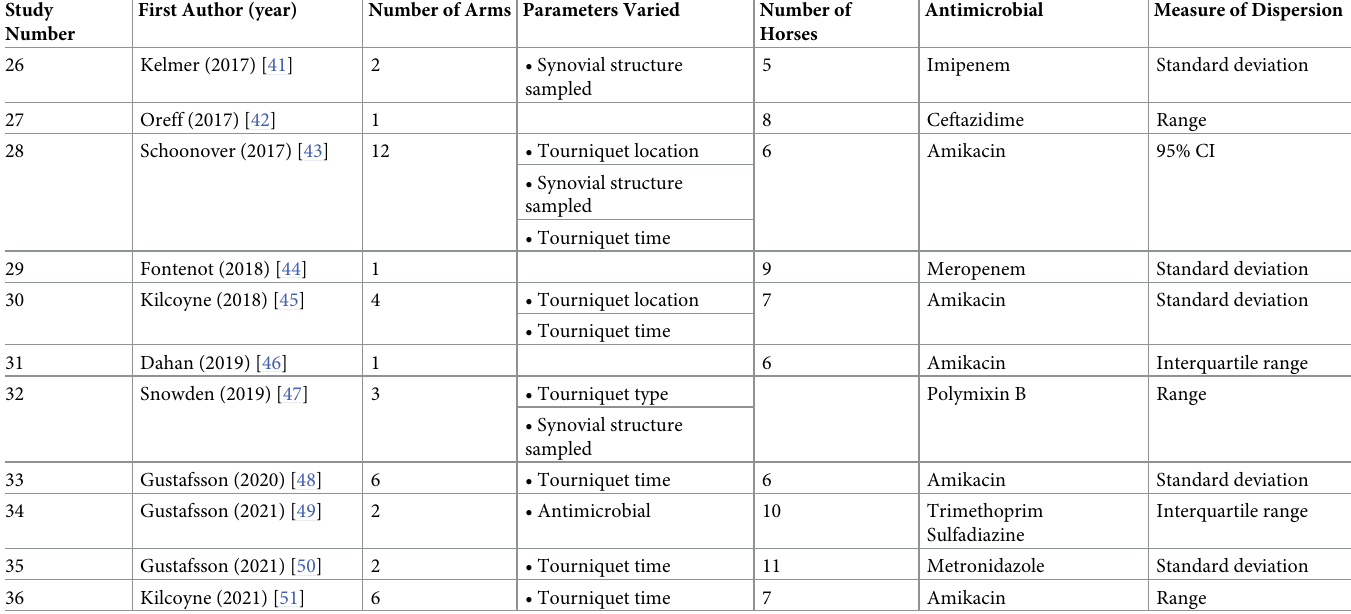
perfusion technique, for a total of 123 permutations of perfusion technique (or “arms”) among all studies. For one study (Kelmer et al. 2013), we were unable to obtain measures of dispersion for one of the arms, therefore the final number of arms in the meta-analysis was 122. The outcome variable Cmax:MIC ranged from 1 to 348 for susceptible organisms, and from 0.25 to 87 for resistant organisms, and the mean (SD) time to peak concentration (Tmax) was 29.0 (8.8) minutes. Meta-analyses generated summary values ( θ ) of 42.8 x MIC and 10.7 x MIC for susceptible and resistant organisms, respectively. However, the heterogeneity in study designs and perfusion parameters (drug, timing, synovial structure, etc.) across studies was high. I 2 , which represents the percentage of residual between-study variation relative to the total variability, was equal to 98.8, which reflects large heterogeneity (S1 and S2 Figs) [52]. As a result, summary measures were not considered reliable. On univariable meta-regression, three variables were statistically significantly associated with the outcome: volume of the perfusate, the type of tourniquet used, and addition of local analgesia. High volumes of perfusate (100–120 mL) resulted in significantly higher (23.4 x MIC, p = 0.014) concentrations than low volumes (30 mL or less). Concentrations were not statistically significantly different for medium (40–60 mL) and low